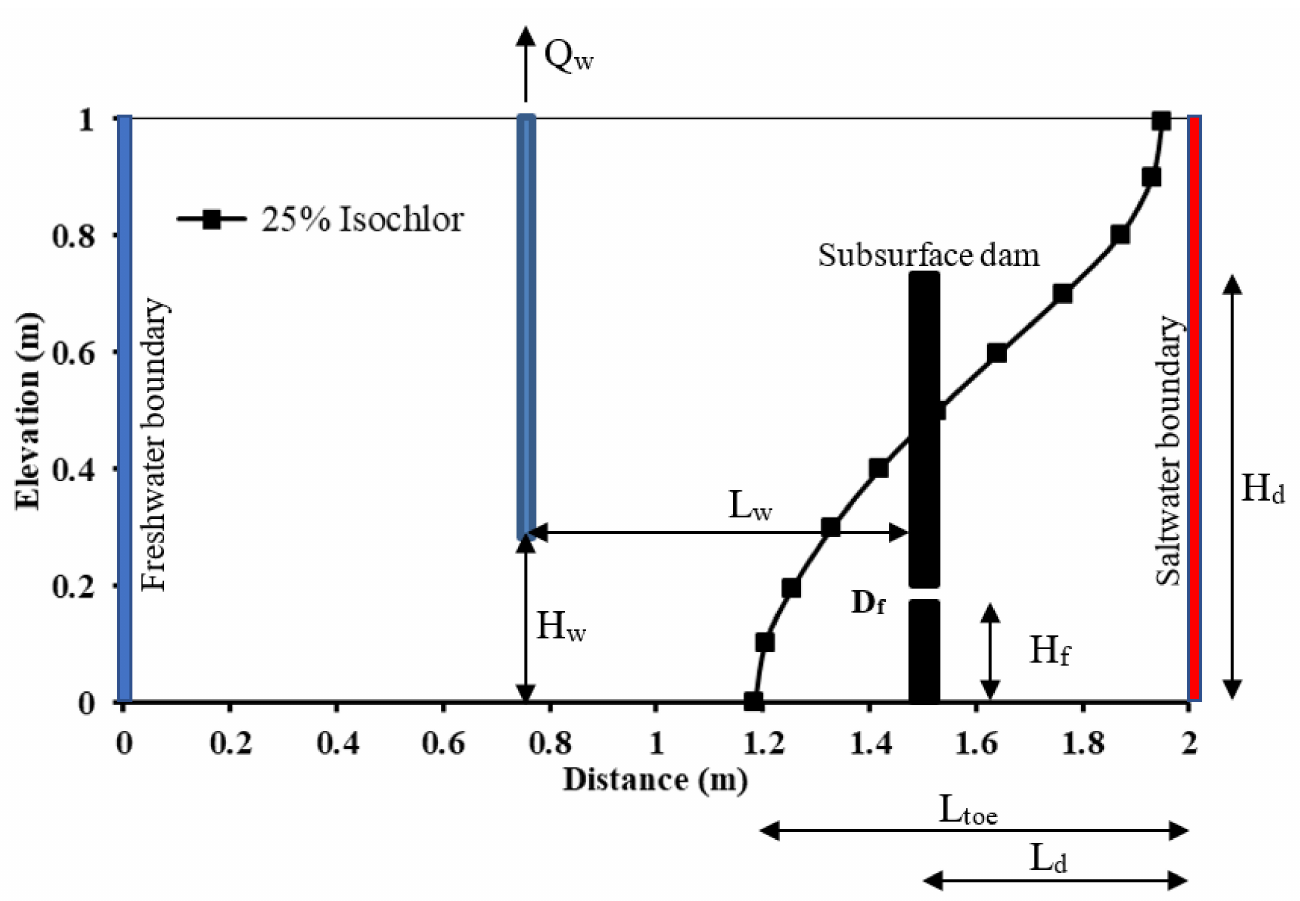
Figure 2. Schematic diagram of the simulated numerical configurations and the main key problem